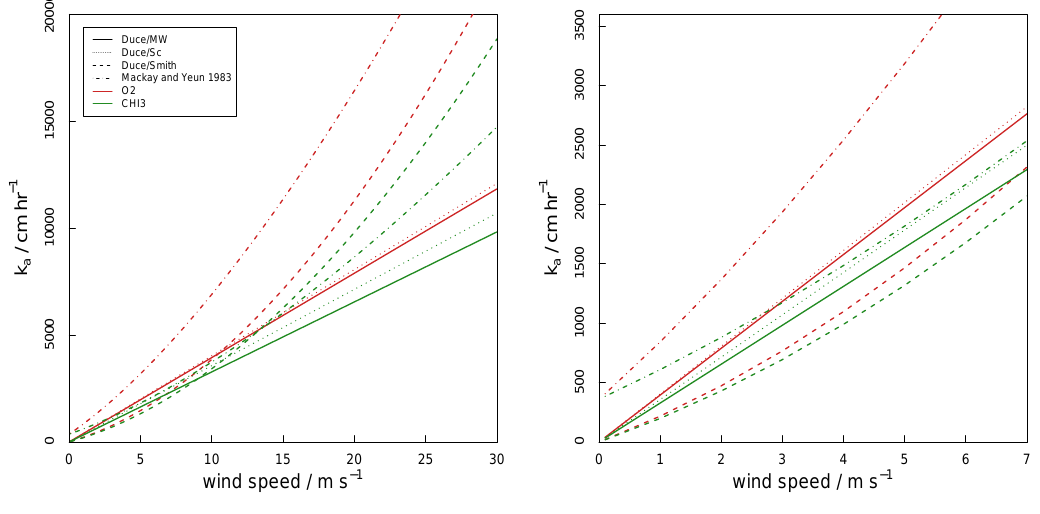
Fig. 2. Comparison of Duce et al. (1991) k a applying different parameterizations of C D with the k a parameterization of Mackay and Yeun (1983), for CH 3 I and O 2 . Duce/MW is the molecular-weight based derivation of k a presented by Duce et al. (1991) (Eq. 6). Duce/Sc corresponds to Eq. 12 with C D = 1.3 x10 − 3 . Duce/Smith corresponds to Eq. 12 with the drag coefficient term from Smith (1980) (Eq.